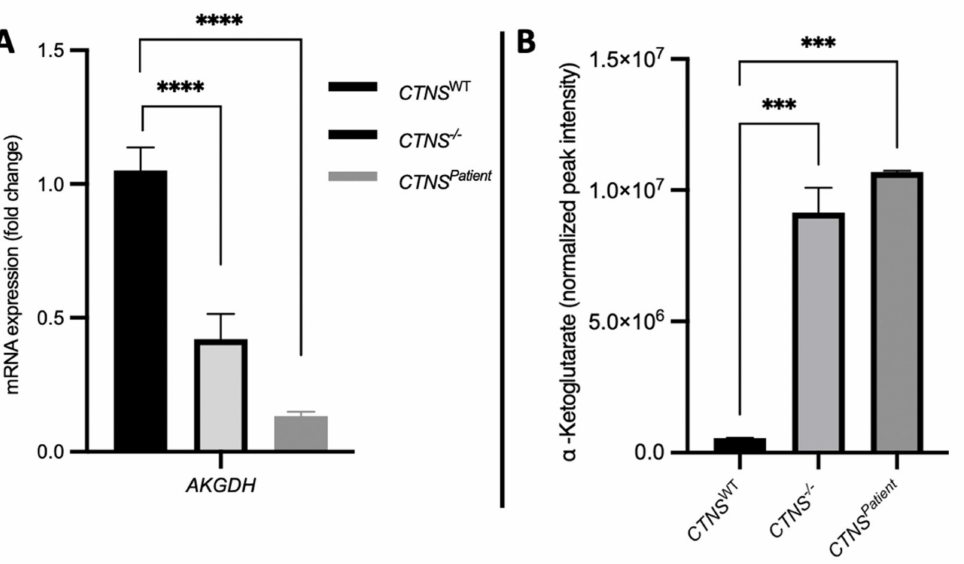
Figure 9. Cystinotic kidney tubules accumulate α -KG. Real-time PCR quantification show a signifi- cant 45% and 89% reduction ( CTNS − / − and CTNS Patient kidney tubules, respectively) of the AKGDH gene ( A ). Cystinotic kidney tubules significantly accumulate α -KG in the cytoplasm ( B ). One-way ANOVA statistical analysis was performed (N = 3; *** p -value < 0.001; **** p -value <